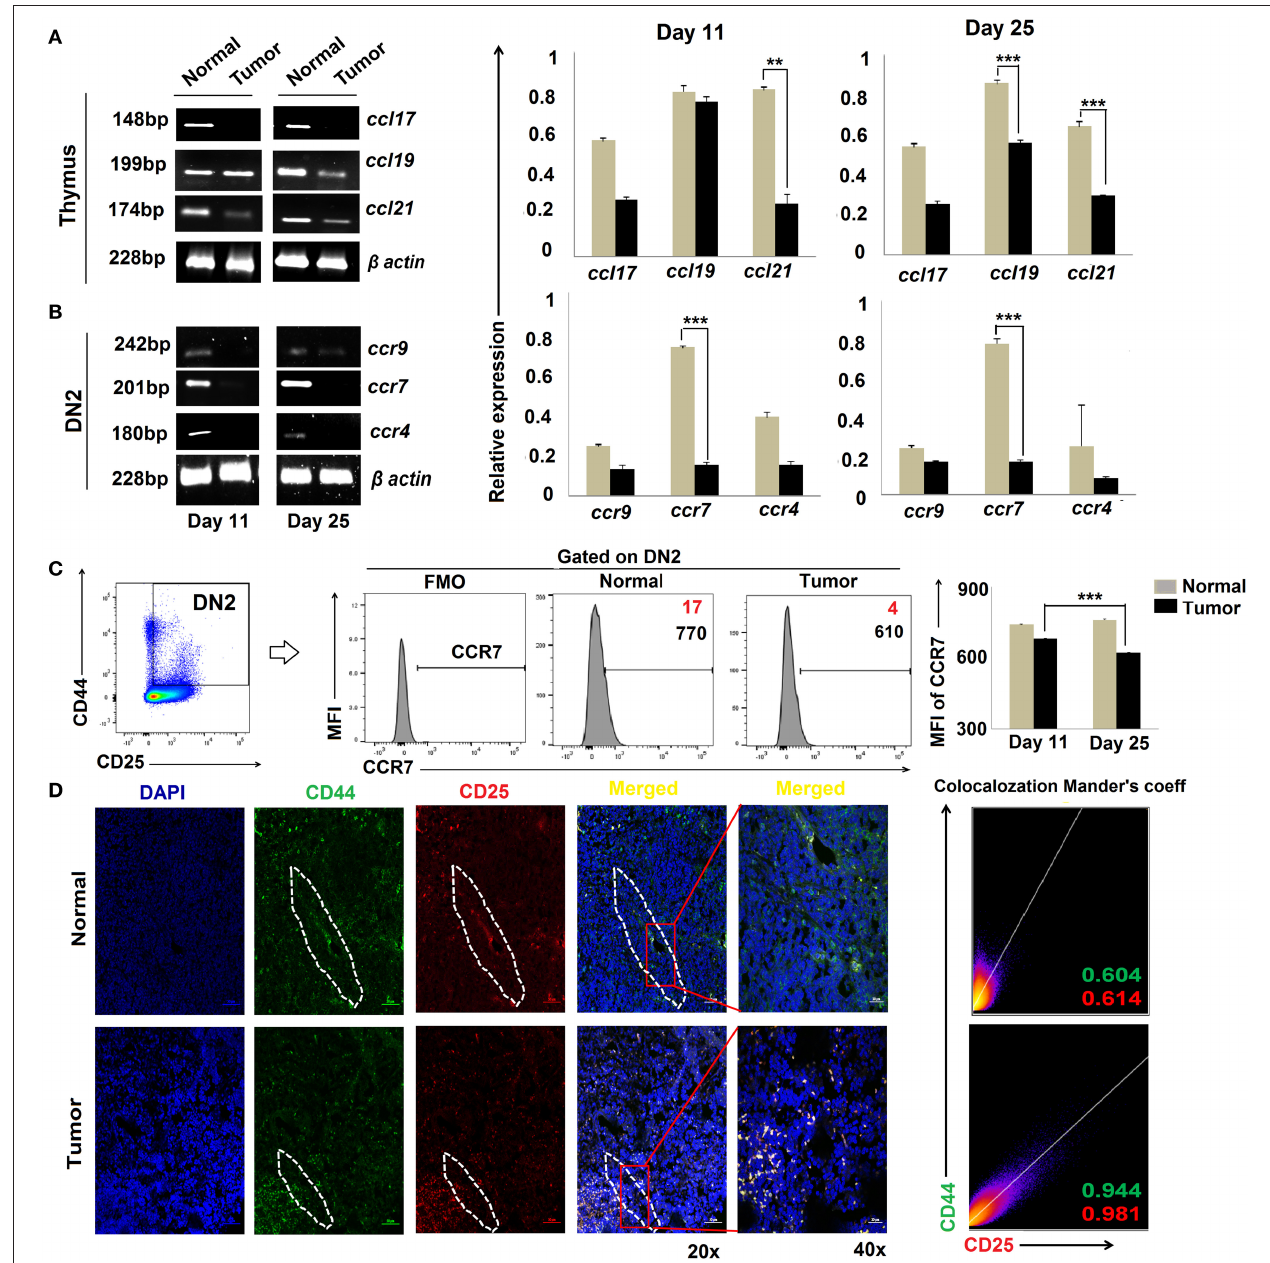
FIGURE 3 | Altered chemokine and chemokine ligand expressions are associated with tumor induced-arrest of DN2-to-DN3 transition: (A) Total thymic cells from normal and tumor hosts on days 11 and 25 ( n = 4 in each group) were isolated to purify mRNA, and expressions of different chemokine ligands ( ccl17 , ccl19 , and ccl21) were assessed by RT-PCR, keeping β -actin as a loading control. Bar diagrams show the mean ± SE of expression of ccl17 , ccl19, and ccl21 from normal and tumor host on days 11 and 25, respectively ( n = 3); ** p < 0.01, *** p < 0.001. (B) Total thymic sorted DN2 (CD25 + CD44 + ) cells were used to isolate mRNAs and analyzed by RT-PCR for different chemokine genes, e.g., ccr9 , ccr7 , and ccr4 , from normal and tumor hosts on days 11 and 25 ( n = 4 in each group), keeping β -actin as a loading control. Representative gene expression pattern is shown in panels. Bar diagrams show the mean ± SE of expression of ccr9 , ccr7 , and ccr4 from normal and tumor host on days 11 and 25 ( n = 4); ** p < 0.01, *** p < 0.001. (C) Flow-cytometric analysis of CD25 + CD44 + CCR7 + thymic cells from normal and tumor-bearing mice. Representative histograms for CCR7 on CD25 + CD44 + (DN2) gated cells, and bar diagrammatic representation shows the mean ± SE of percentage positive CD25 + CD44 + CCR7 + cells, where positive percentages of cells are shown in red, and bar diagram represents the mean ± SE of MFI of CD25 + CD44 + CCR7 + cells; n = 4 in each group; *** p < 0.001. (D) Immunofluorescence staining was performed with CD25-PE and CD44-FITC on thymuses from normal and tumor hosts. Representative DAPI, CD44-FITC, CD25-PE, and merged figures of stained tissues show single staining and the co-localization of CD25 and CD44 in tissues from normal and tumor hosts. Dotted regions indicate the CD44 + CD25 + -localized CMJ regions in both cohorts. Representative 2D intensity histogram represents co-localization of CD25 and CD44; Manders’ co-efficient represents the intensity and index of co-localization. Value close to 1 indicates reliable co-localization.